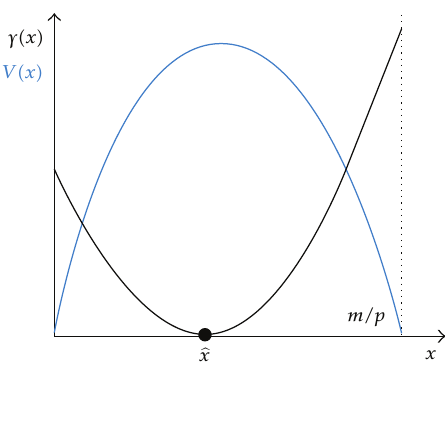
Figure 3: Consumer without learning versus consumer endowed with